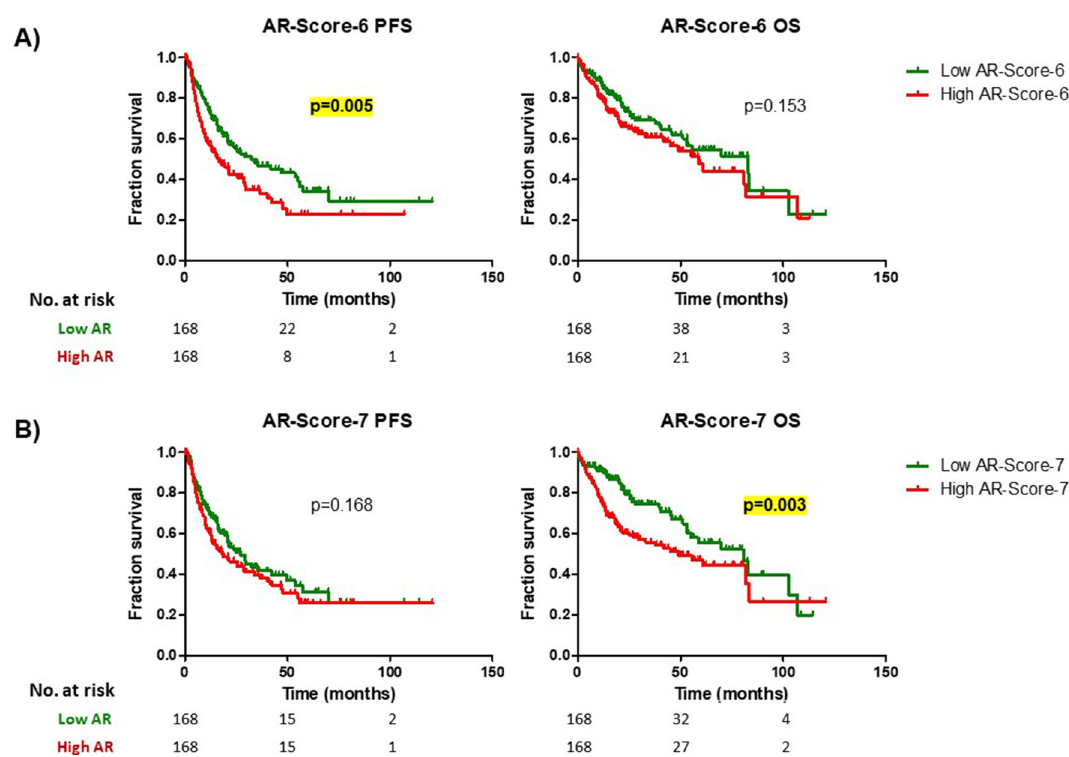
Figure 6. Survival analysis (progression free survival [PFS] and overall survival [OS]) in different AR-Score-6 ( A ) and AR-Score-7 groups ( B